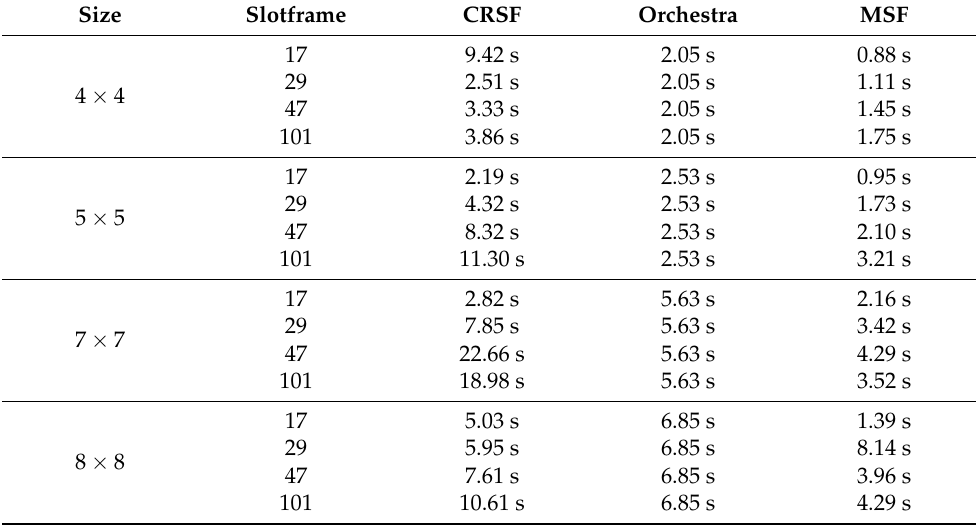
Table A6. Results for end-to-end latency (in seconds) with a burst traffic